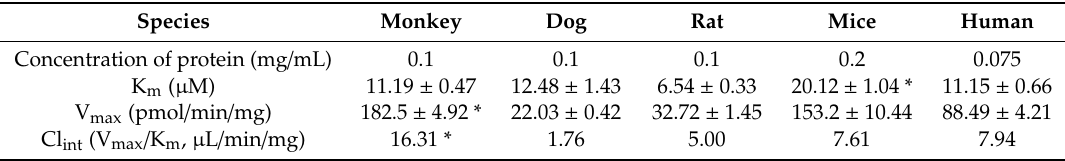
Table 2. Enzyme kinetic parameters of GL-V9 in rUGT1A7, rUGT1A8 and rUGT1A9 incubation systems (mean ± SD, n = 3). Species Concentration of protein (mg / mL)